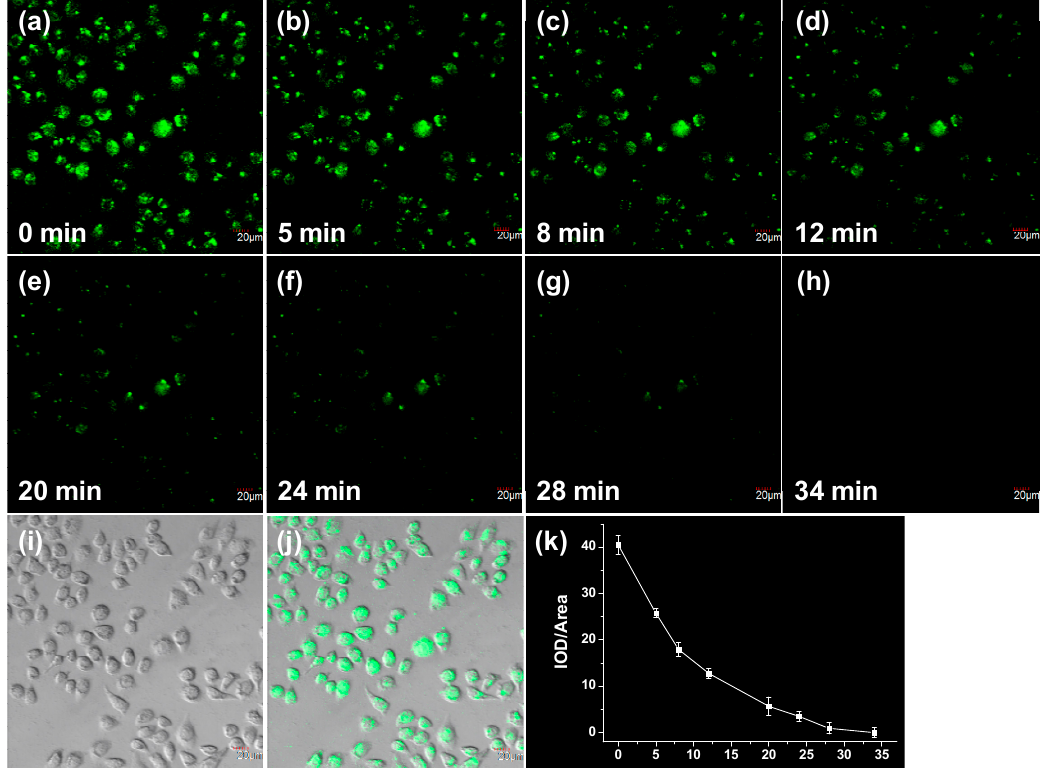
Figure 7. CLSM images of L -loaded HeLa cells incubated with ATP (4 µ M) for various times from 0 to 34 min ( a – h ). ( i ): Brightfield; ( j ): Overlay of (a) and (i); ( k ): Dot representing the integrated optical density (IOD / area) of the probe L from the fluorescence images at each time point. Scale bars: 20 µ m. λ ex = 405 nm, λ em = 564–633 nm. Error bars represent the standard deviations of three independent experiments.